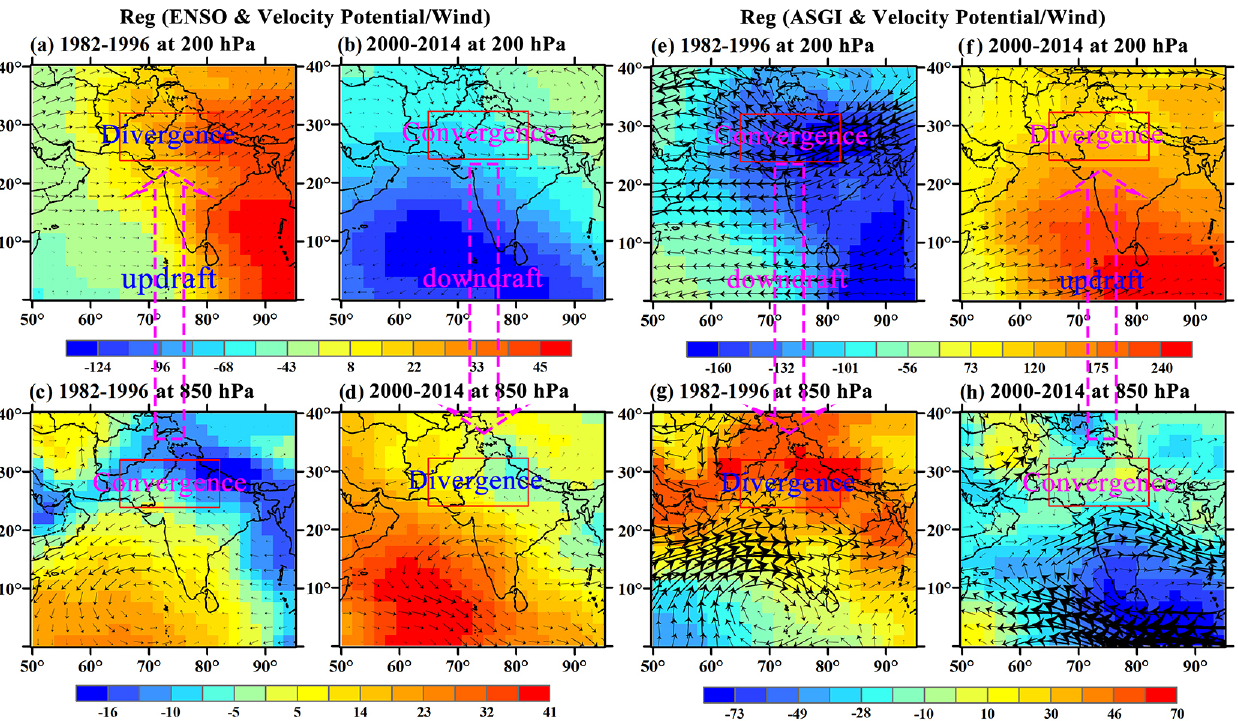
Figure 9. (a–d) Regression of ENSO with ASGI-related signals removed onto velocity potential (VP) and wind at 200 and 850hPa in the dust season (June–July). (e–h) Regression of ASGI with ENSO-related signals removed onto velocity potential and wind at 200 and 850hPa in the dust season (June–July).